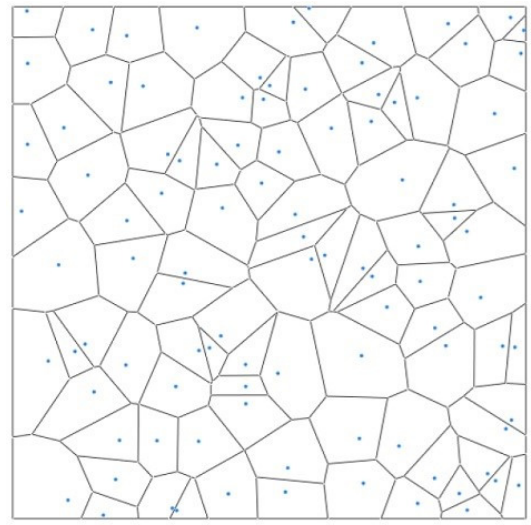
Figure 3. Schematic diagram of Voronoi polygon.